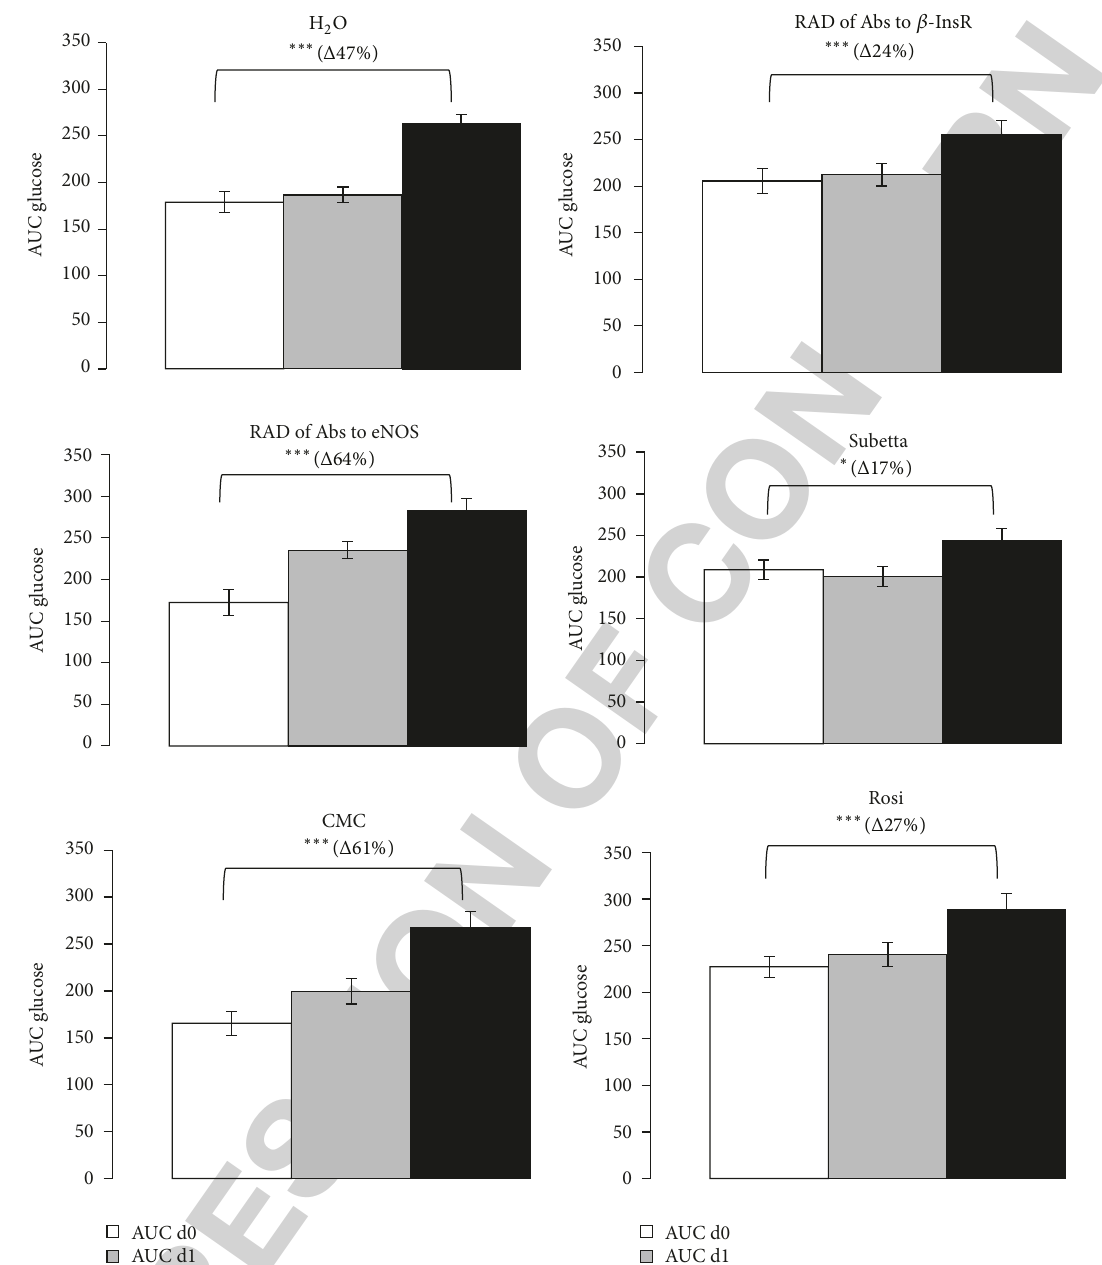
Figure 1: Glucose tolerance to glucose (2g/kg per os) in adult diabetic male GK/Par rats before (d0), after acute treatment (d1), and after chronic treatment (d28) with RAD of Abs to 𝛽 -InsR, RAD of Abs to eNOS, Subetta, H 2 O (distilled water), Rosiglitazone (Rosi), or carboxy- methyl-cellulose (CMC). On d1 and d28, drugs or vehicle were administrated at 9.00. OGTT were performed at 12.00 in nonanaesthetized rats fasted from 9.00 (postabsorptive state). Glucose responses during the glucose tolerance test were calculated as incremental plasma glucose values integrated over the 120 min period following the glucose injection (AUC glucose; g/L/120min). Each point represents the mean ± S.E.M. of 12 observations/group. ∗∗∗ 𝑃 < 0.001 versus the related d0-value within each group. ∗∗ 𝑃 < 0.01 versus the related d0-value within each group. ∗ 𝑃 < 0.05 versus the related d0-value within each